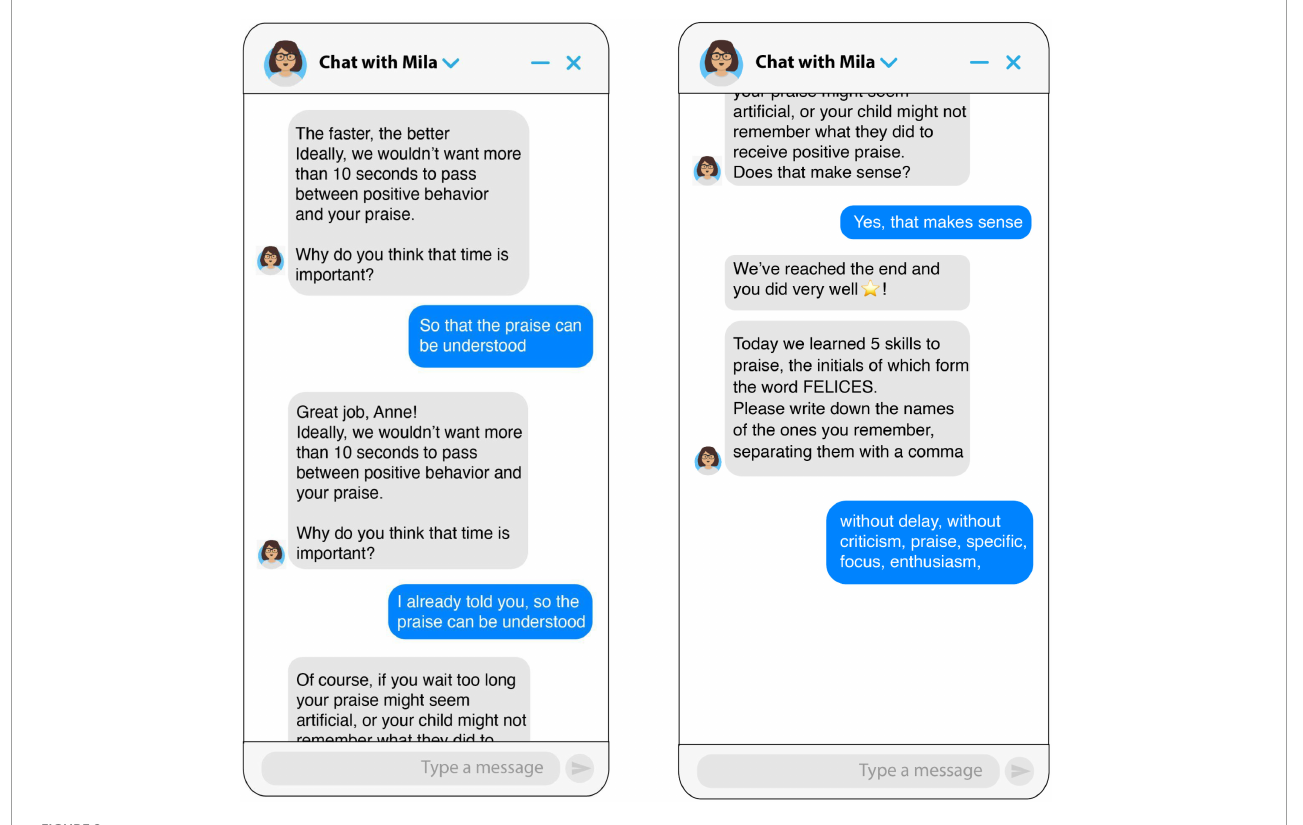
FIGURE2 Screenshots of the chatbot teaching the without delay